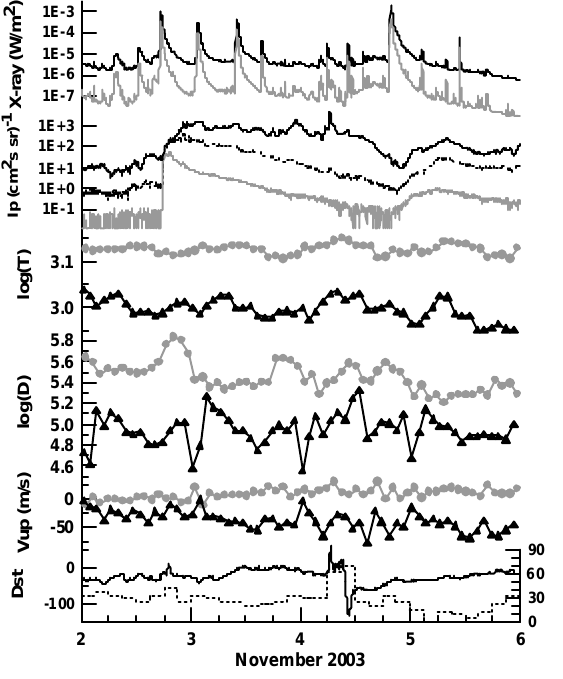
Fig. 3. The same as in Fig. 1 but for time interval 2-5 November Figure 3. The same as in Figure 1 but for time interval 2-5 November 2003.